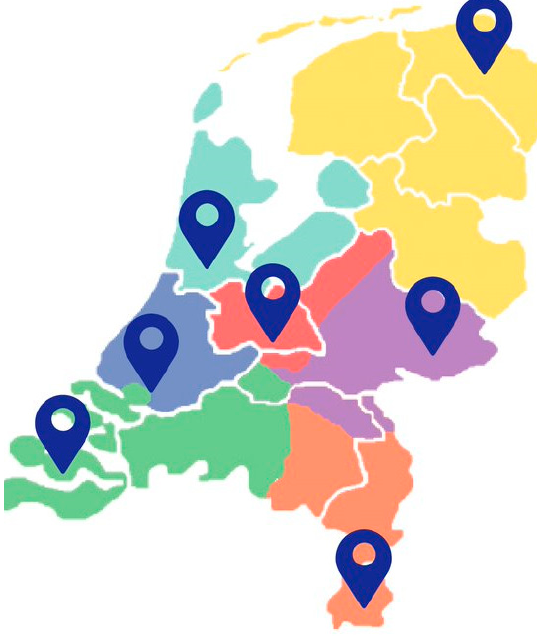
Figure 2. Map of the Netherlands with the seven areas of the nationwide structure